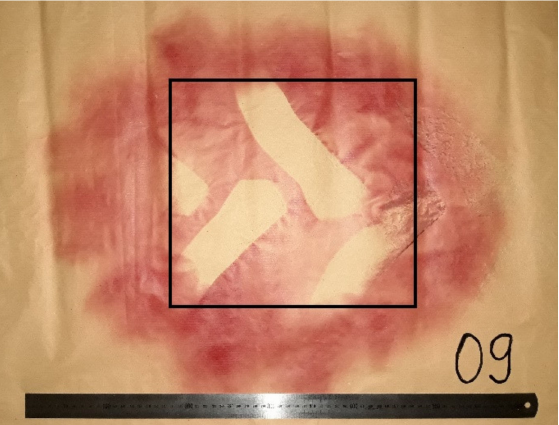
Figure 2. The outer boundaries of the tire tread imprint, front axle, tire inflation 250 kPa, load 0 kg. Actual pressures in the soil were measured by a measuring device (Figure 3) with the pressure sensor consisting of a strain gauge connected with a pressure probe, recording unit MultiHandy 3020 and notebook with the software for data processing. The pressure probe (flexible plastic container of cylindrical shape with a diameter of 30 mm and length of 140 mm) was connected to the strain gauge by means of a reinforced rubber